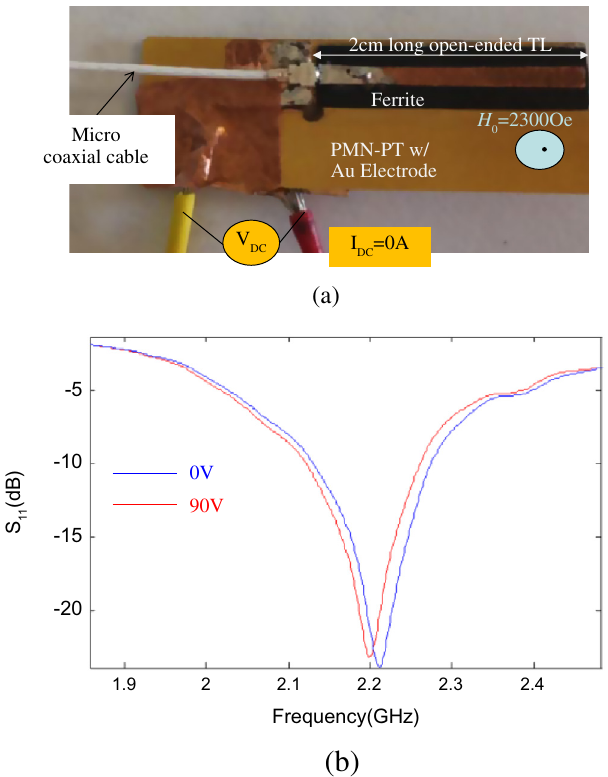
Figure 15. (a) In house manufactured open ended TL resonator based on magnetoelectric composite comprised of 15 mil thick YIG ( e r = 15, tan d = 1e-4, 4 p M s = 1780 G, D H = 20 Oe) film bonded to 15 mil thick PMN-PT layer. (b) Corresponding input reflection coefficients for V DC = 0 and 90